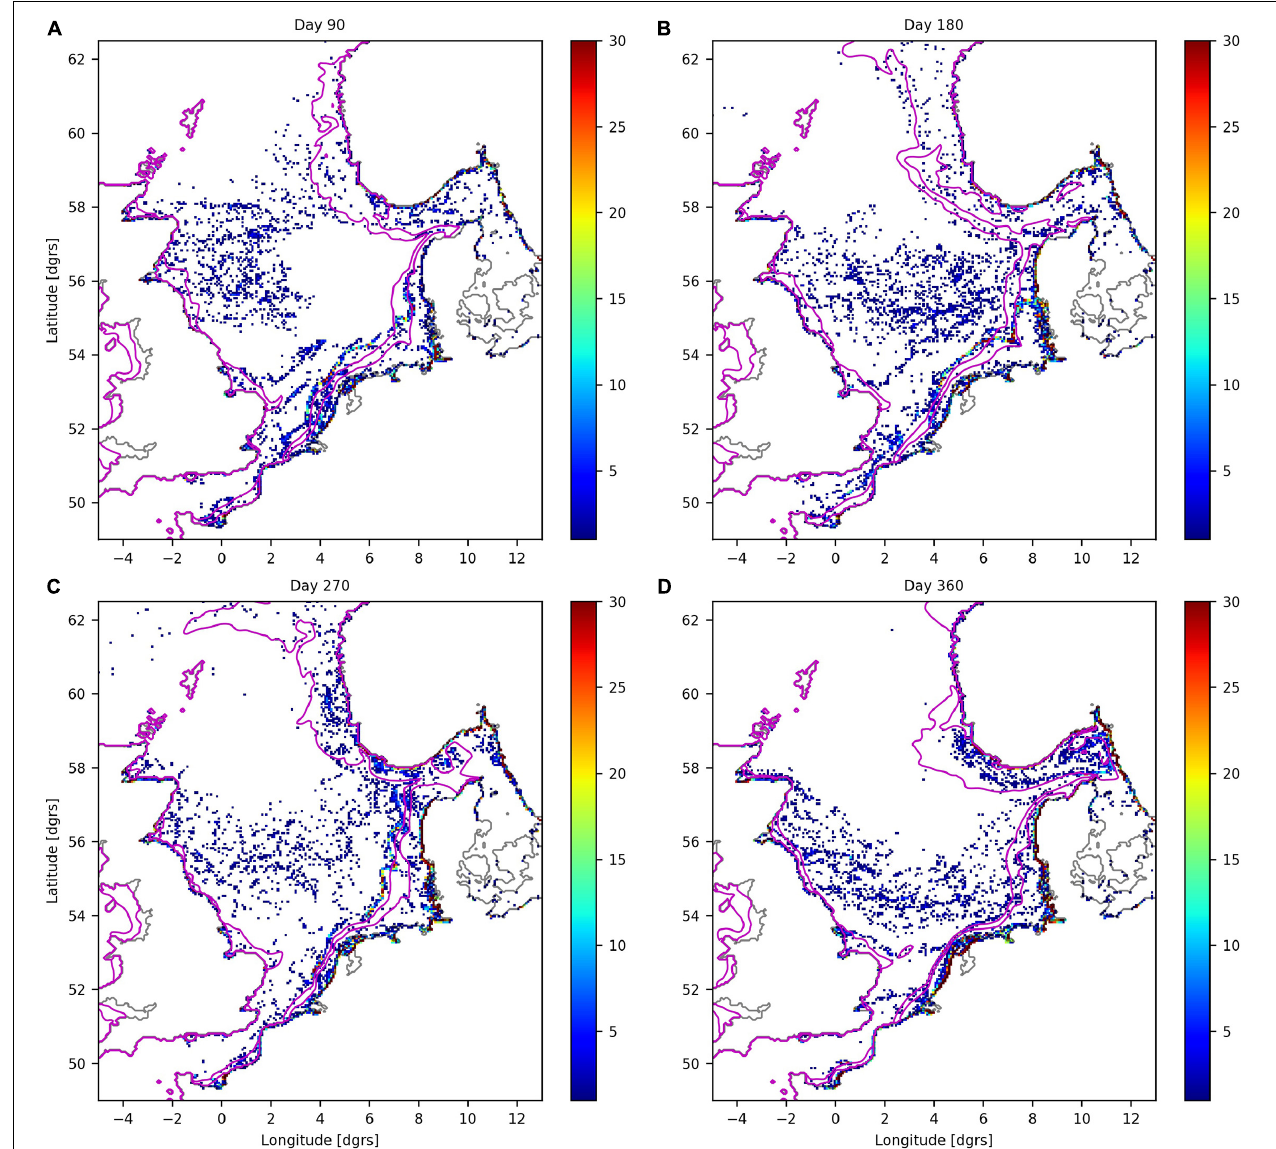
FIGURE 11 | Particle densities (number of particles per grid cell) for the proportional release experiment for floating particles, for four time slices during the simulated year in 90 day intervals, with 33.0 and 34.5 salinity contours (magenta lines). (A) 31 March, (B) 29 June, (C) 27 September, and (D) 26